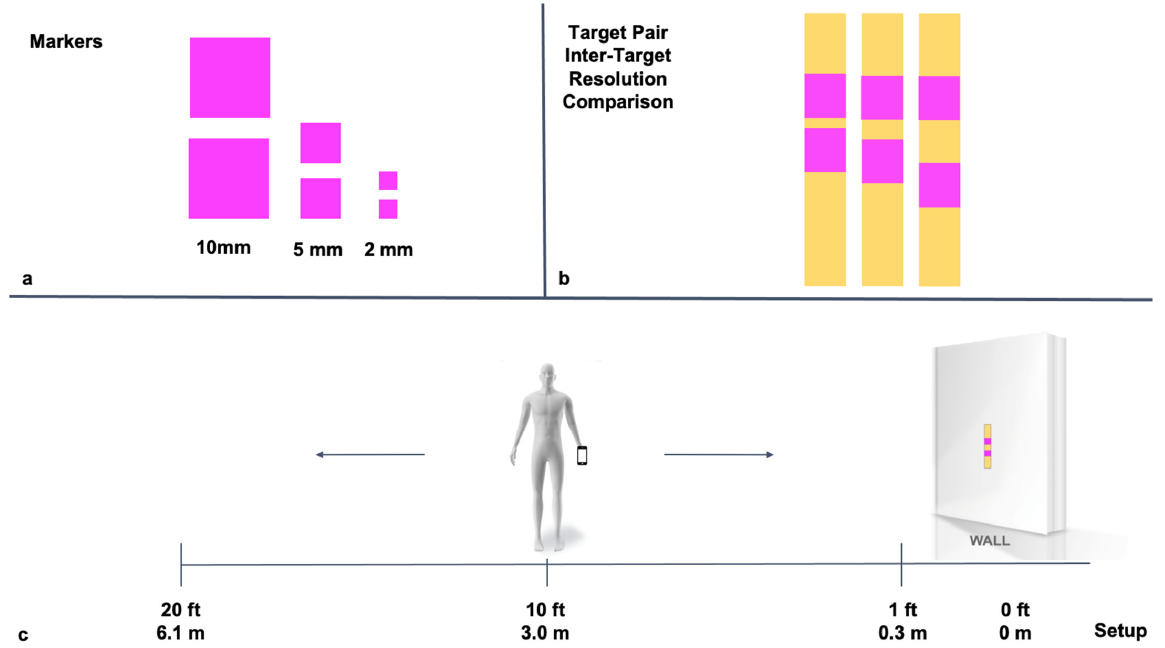
Figure 4. Protocol 2: Configuration for distance limit of target pair detection and inter ‐ target dis ‐ crimination. Neon pink or green markers were cut in either, 2 mm, 5 mm, or 10 mm sizes ( a ). Markers were affixed to flat wood stick in either 2 mm, 5 mm, or 10 mm distances apart ( b ). As in Protocol 1, videos were captured at 1 ft increments ( c ).